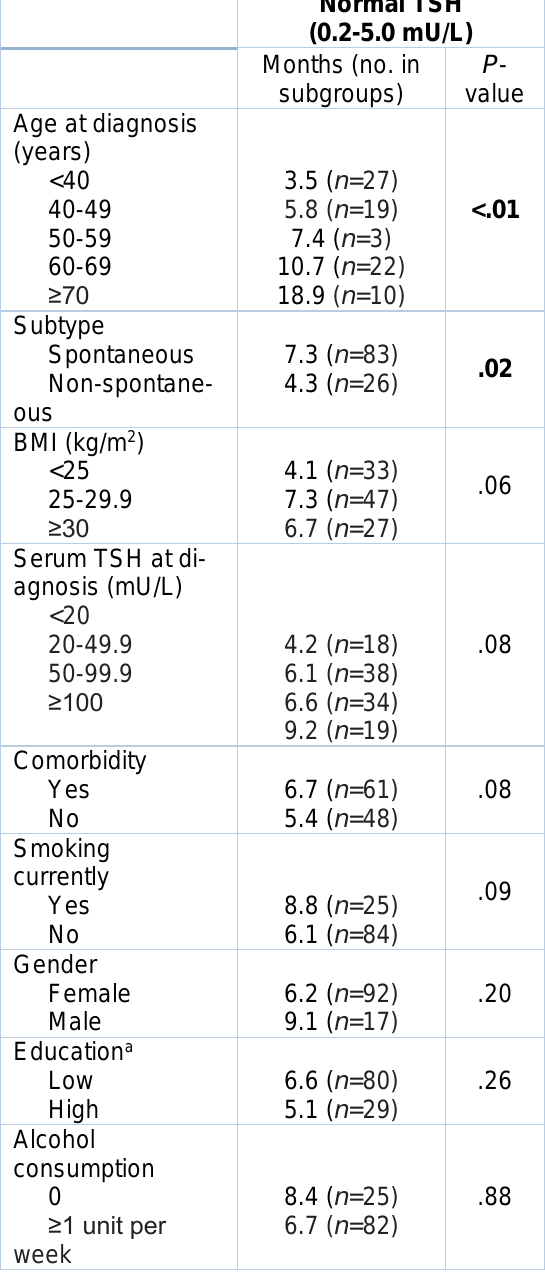
Table 2: Univariate analysis showing median months to first normal TSH among subgroups within various clinical and demographic variables Normal TSH (0.2-5.0